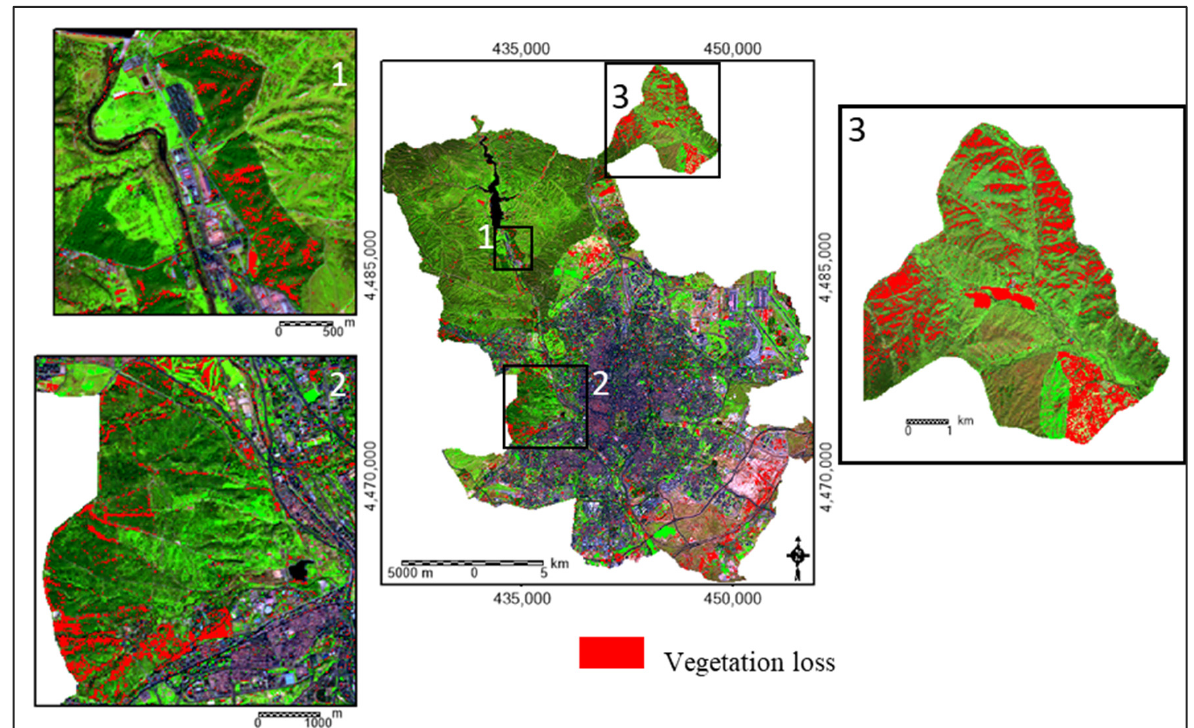
Figure 9. Loss of vegetation in the municipality of Madrid and details in different sectors, obtained through the image of changes in the NDVI between February 2020 and 2021. 1: Repopulation pine forests of Monte de El Pardo. 2: Repopulation pine forests of Casa de Campo; 3. Holm oak and pine forests to the north of the municipality. Sources Copernicus Sentinel Hub [48].